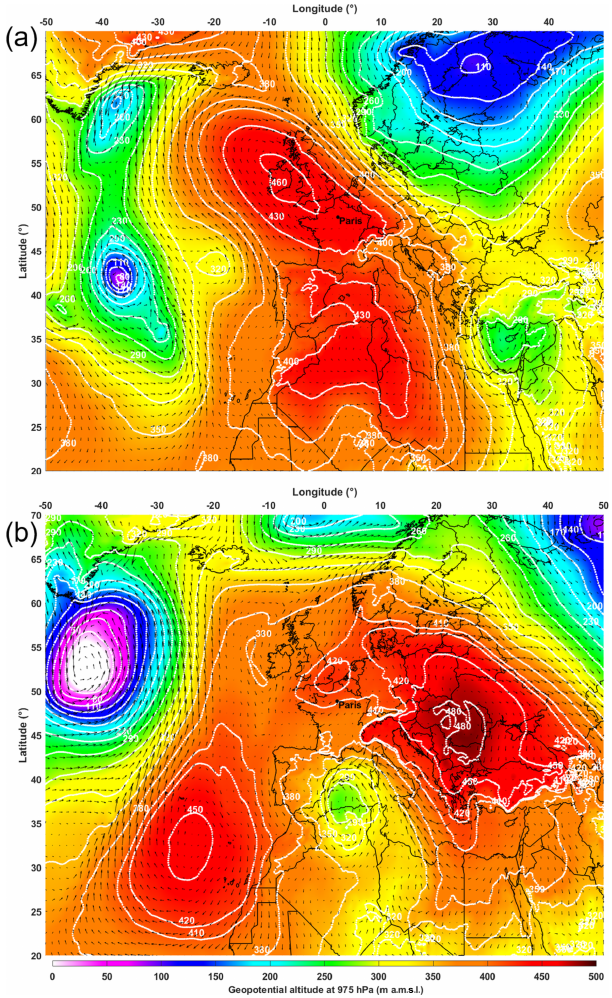
Figure 3. (a) Weather situation on 1 December 2016 at 12:00 UTC and (b) on 22 January 2017 at 12:00 UTC taken from ECMWF ERA-5 reanalysis. The geopotential altitude (white lines) and the wind direction and velocity (black arrows) are given at a 975hPa level. Maximum wind speed is 27.8ms − 1 (31.6ms − 1 ) at 57.75 ◦ N 28.25 ◦ W (62.25 ◦ N, 39.5 ◦ W) in the top (bottom) map. Minimum wind speed is 0.02ms − 1 (0.03ms − 1 ) at 50.5 ◦ N, 6.5 ◦ E (46.25 ◦ N, 7.75 ◦ E) in the top (bottom)